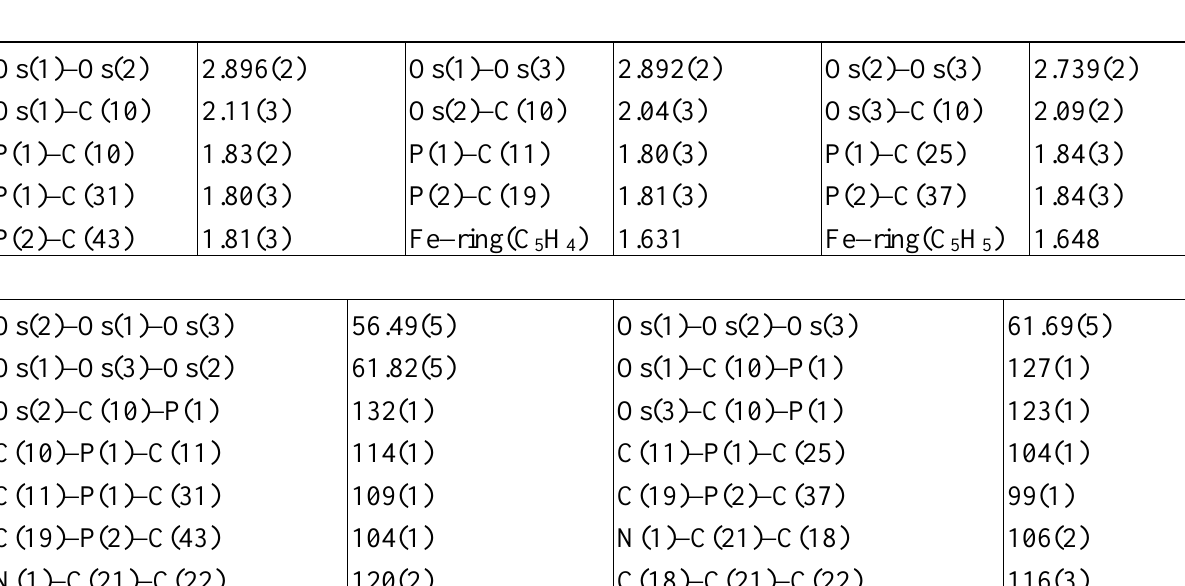
Table 1. Selected bond distances (Å) and angles ( ° ) for 1